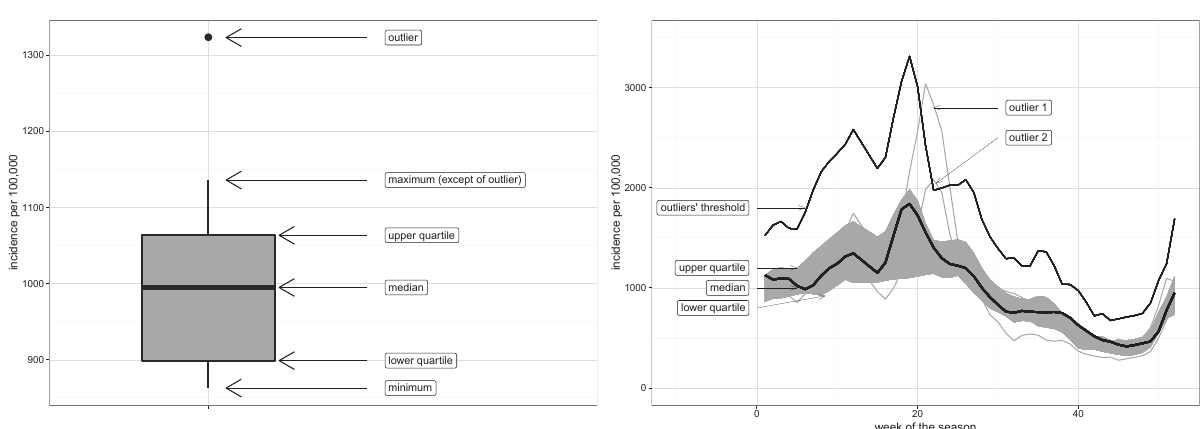
Fig. 1. Classical boxplot (left) and boxplot for functional data (right), as described in the section Boxplot for functional